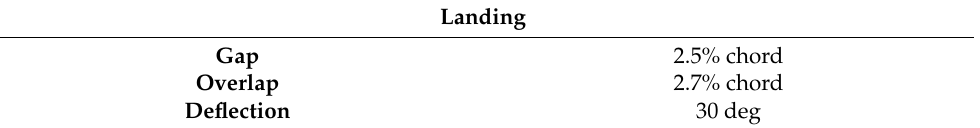
Table 12. Flap position landing.